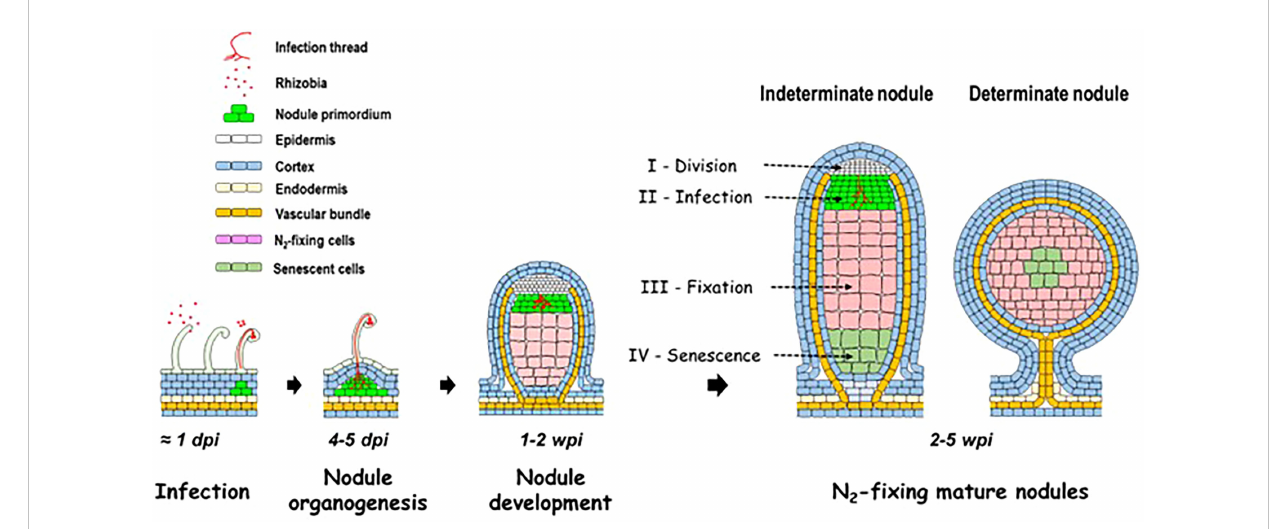
FIGURE 1 Schematic representation of the establishment and of the development of the legume – rhizobium symbiosis, and of the structure of mature indeterminate and determinate nodules. dpi, day post-inoculation; wpi, week